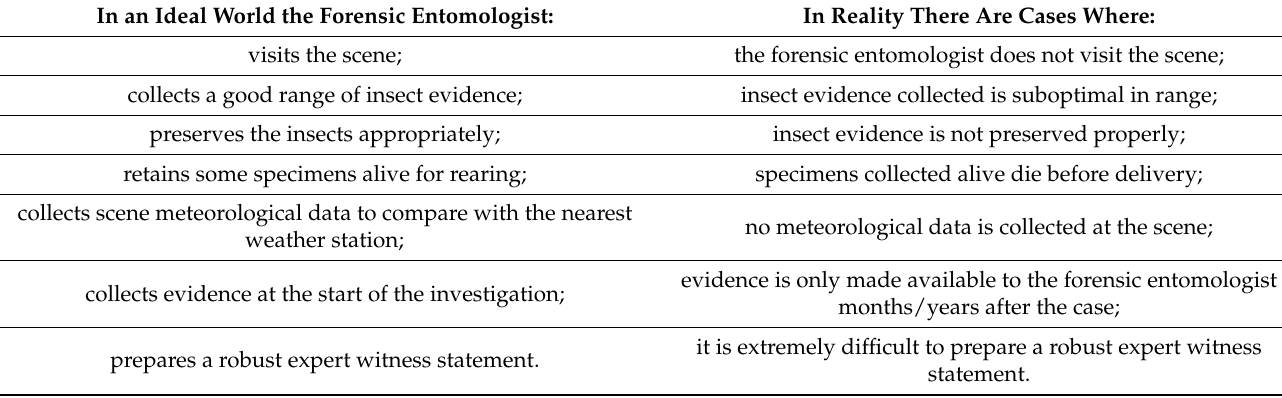
Table 2. Examples of differences between collection and analysis of forensic entomology evidence in an ideal world and in reality. In an Ideal World the Forensic